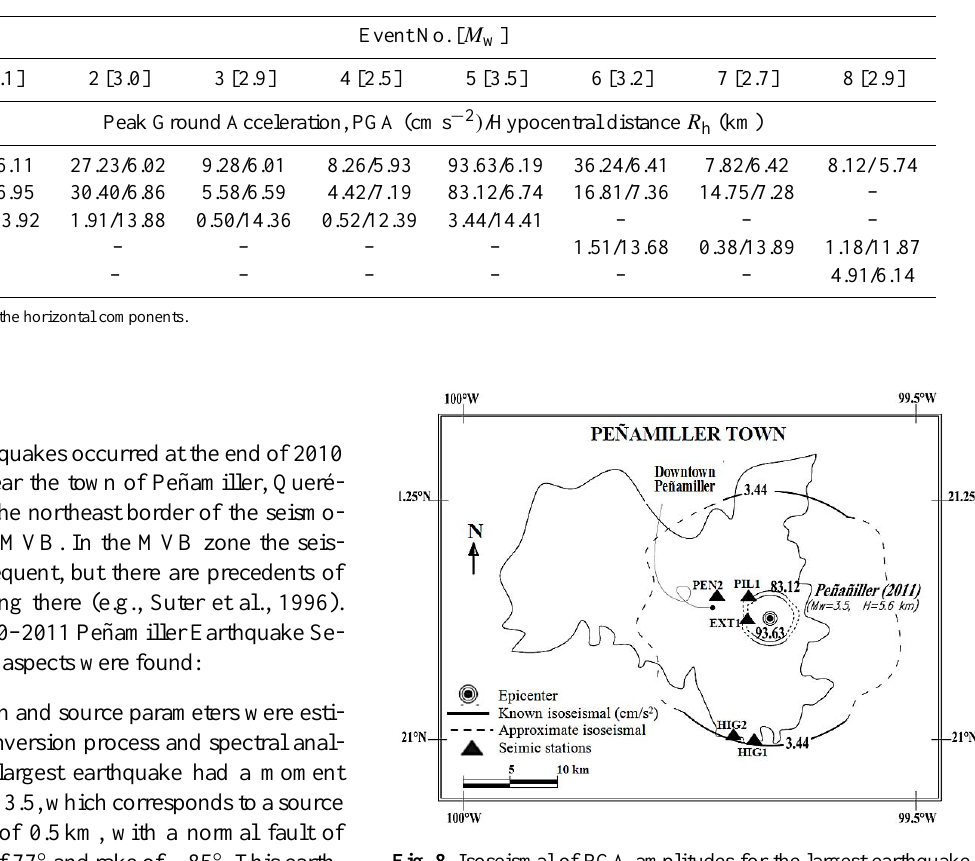
Fig. 7. Rose histograms: (a) Direction of maximum vertical ( σ 1 ) and (c) minimum horizontal compressive stresses axes ( σ 3 ) . (b) A repre- sentation of the principal stress axes in a block-diagram of a normal fault. Table 8. Amplitude of peak ground acceleration with respect to hypocentral distance from all events in each station.